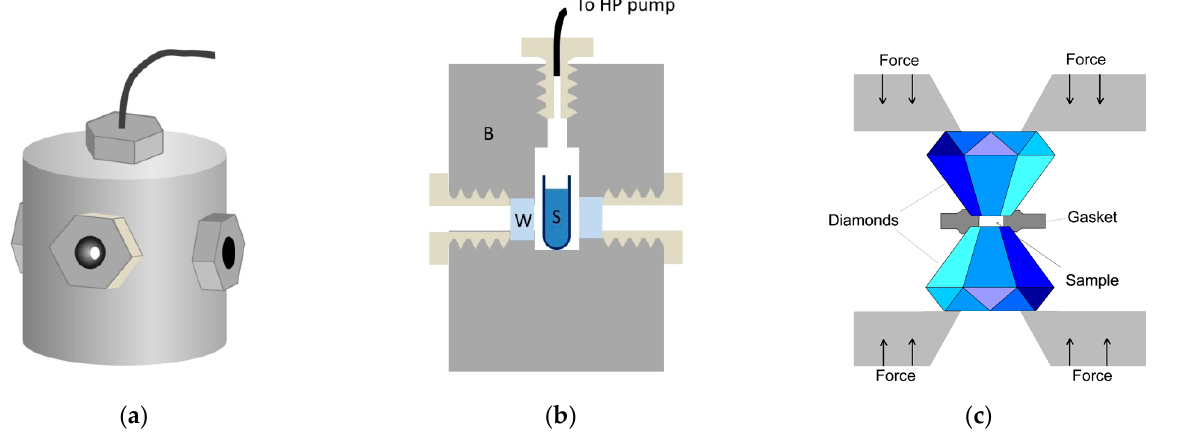
Figure 2. High pressure instrumentation. ( a , b ) View and structure of the thick-wall cylinder-type high pressure optical cell. B: cell body, W: optical window S: sample solution. ( c ) Schematic view of the diamond anvil cell.